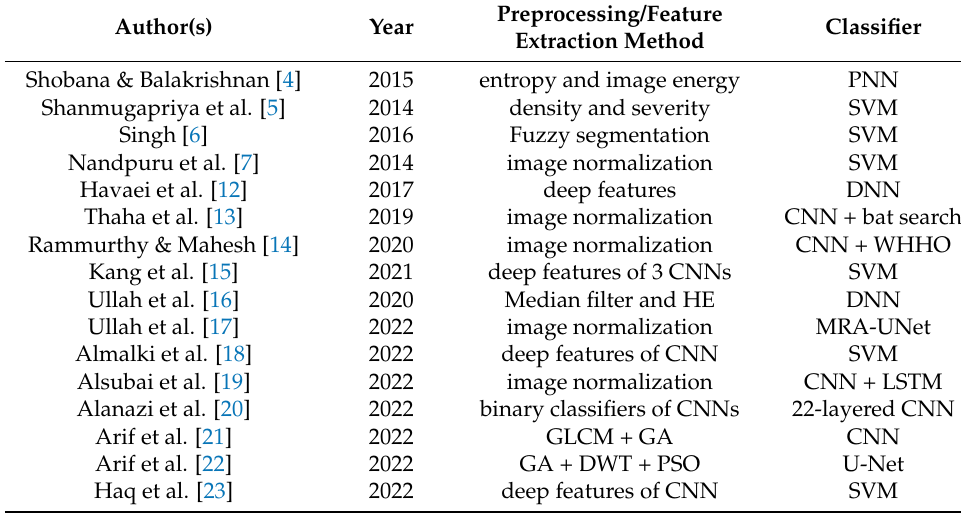
Table 1. Summary of the related